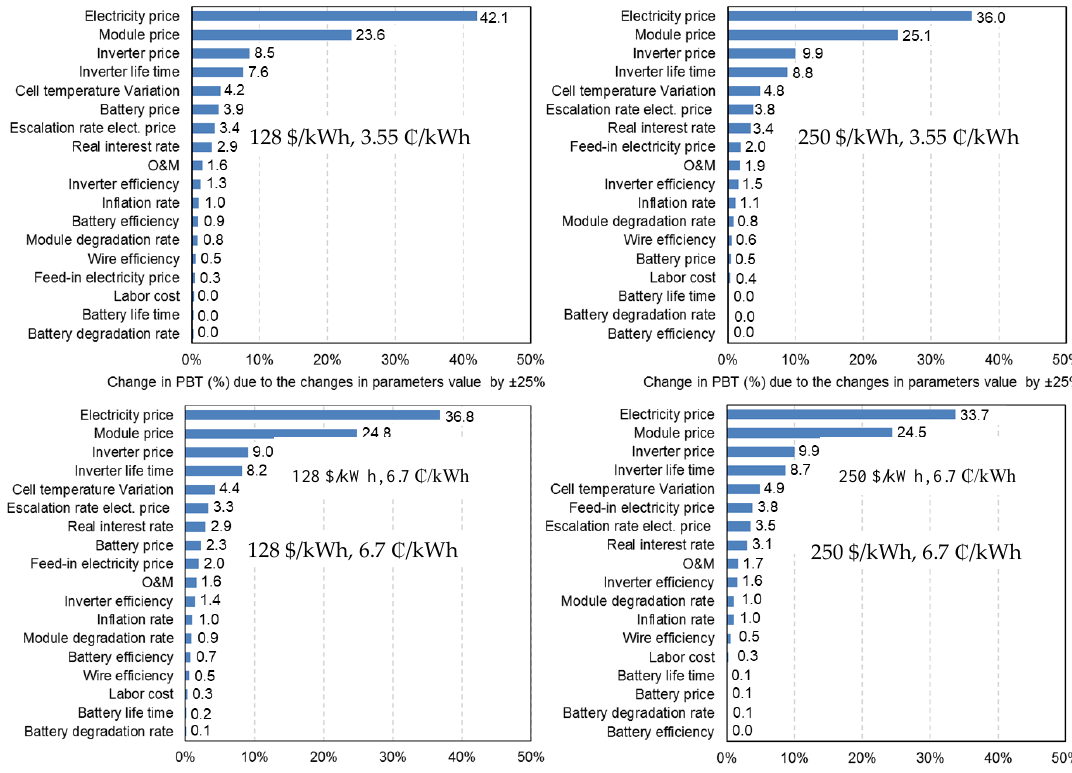
Table 2. Assumptions made in the present work.